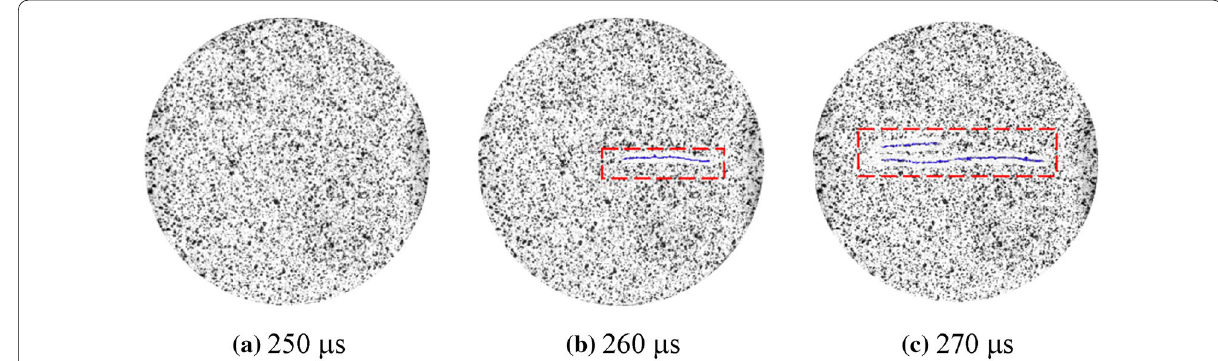
Fig. 10 Crack initiation in the center of the PP-0.5-3-1 specimen